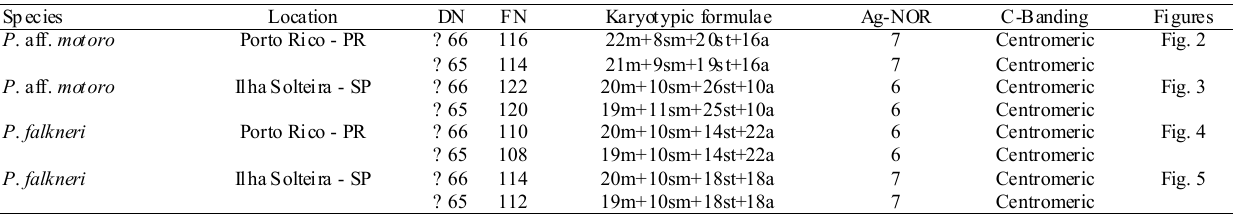
Table 1. Data and cytogenetic karyotypic formulas analyzed in populations of specimens of species of rays Potamotrygon aff.